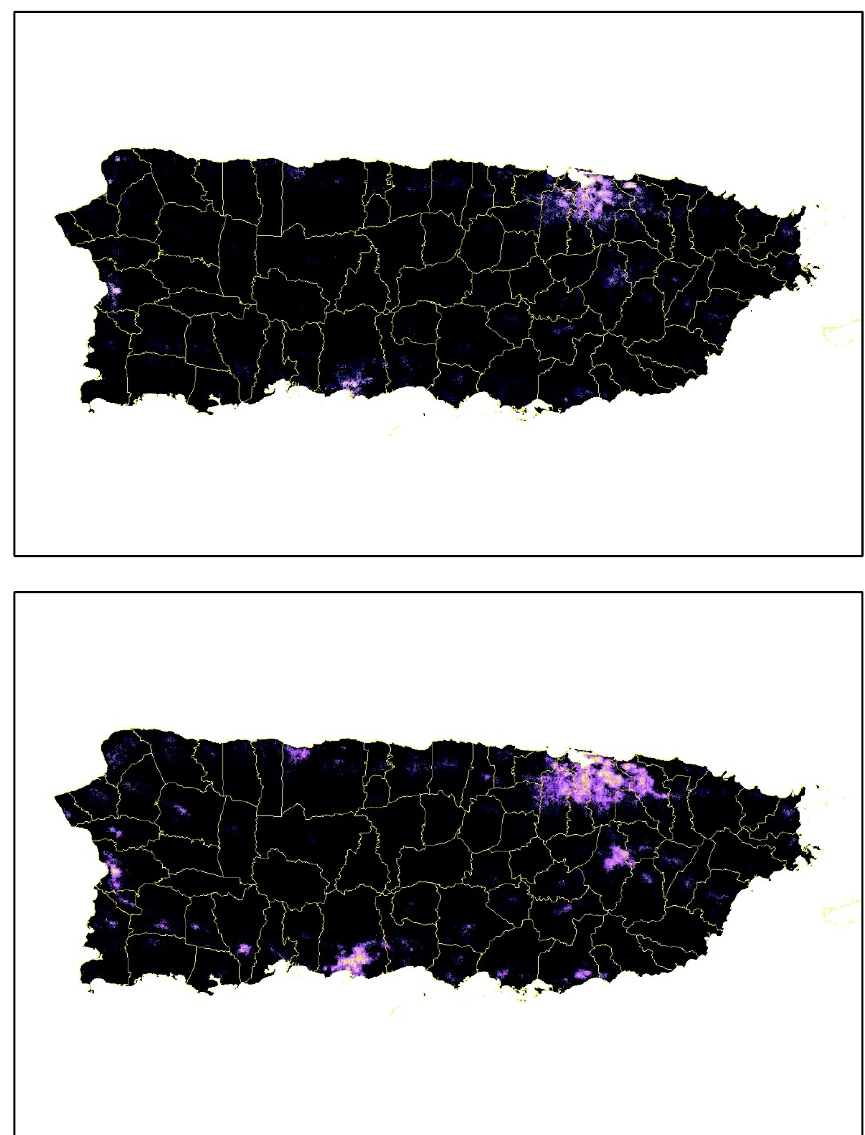
Figure 5. Upper panel: Lights before the storm; center panel: Lights after the storm (20 September– 20 November 2017), lower panel: Four months after the storm (21 November 2017–2020 January 2018). Source [55] .